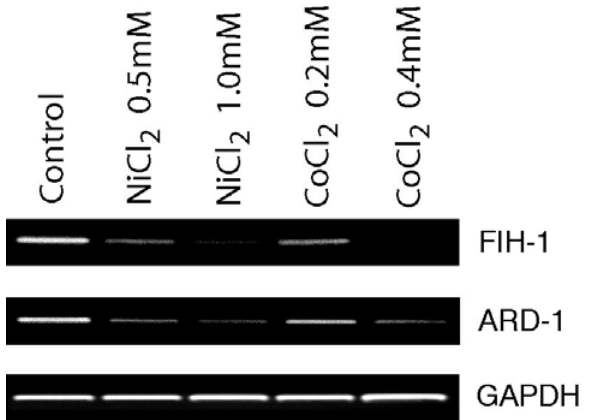
Figure 1: Nickel (II) and Cobalt (II) down-regulate mRNA levels of FIH-1 and ARD-1genes in A549 cells ·6H O (0.5mM and 1 A549 cells were treated with NiCl 2 2 ·6H O (0.2 mM and 0.4mM) for 24 h. The mM) or CoCl 2 2 cells were harvested at the end of the treatment and the mRNA was isolated. The FIH-1, ARD-1, and GAPDH genes were amplified by